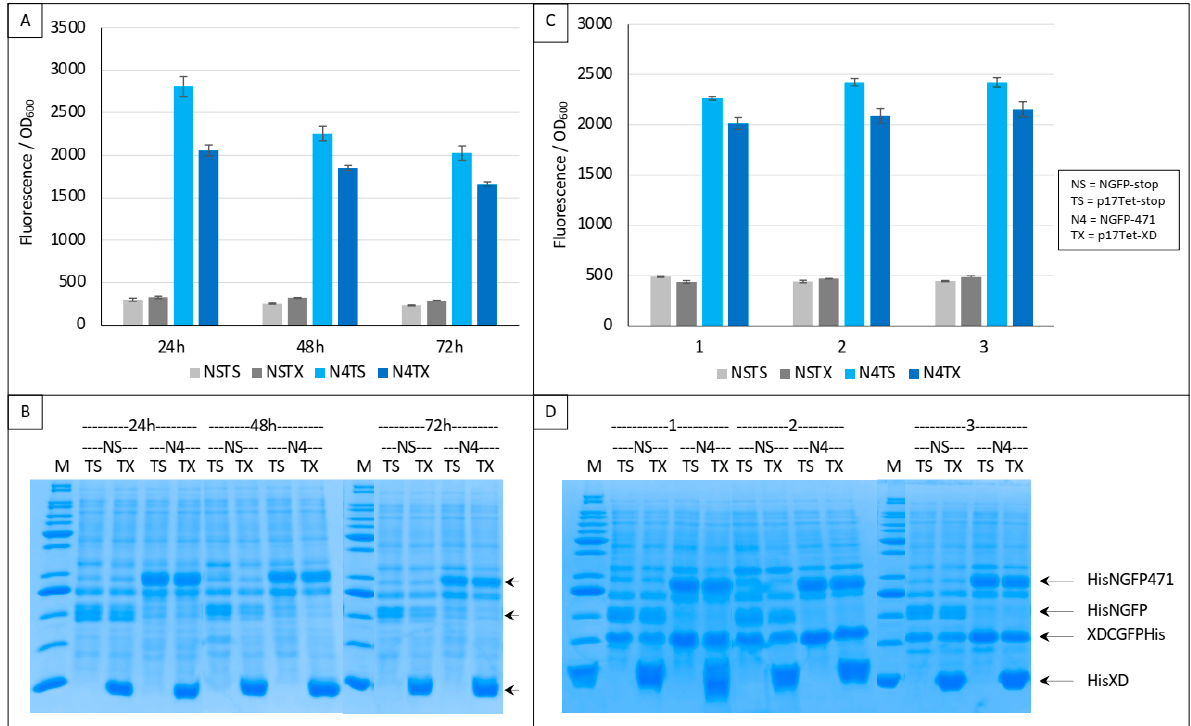
Figure 7. Split-GFP reassembly competition assay using NGFP-471, XD-CGFP, and His-XD as competitor. ( A ) Fluorescence data as obtained from an experiment performed in triplicate for 24, 48 or 72 h. NSTS and NSTX are the two negative controls. TX is free XD used as competitor. See main text for a description of NSTS, NSTX, N4TS and N4TX. ( B ) SDS-PAGE analysis of panel A. M, molecular mass markers (200, 150, 100, 85, 60, 50, 40, 30, 25, 20, 15, 10 kDa). ( C ) Fluorescence data as obtained from three independent experiments (labeled 1, 2, 3 on the x -axis), each performed in triplicate for 24 h. The difference between panel A and C is that experiments shown in panel C used a His-tagged version of XD-CGFP. ( D ) SDS-PAGE analysis of panel C. M, molecular mass markers (200, 150, 100, 85, 60, 50, 40, 30, 25, 20, 15, 10 kDa).